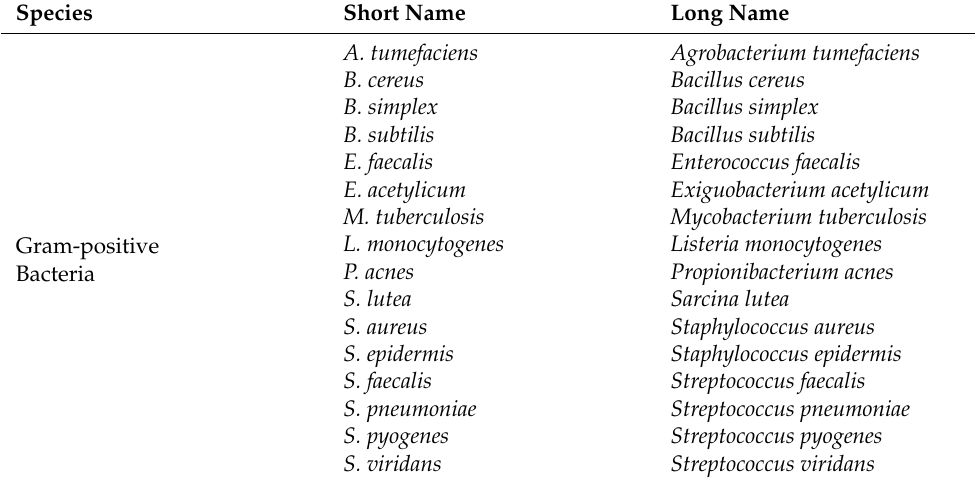
Table A1. Species of microorganisms mentioned in the